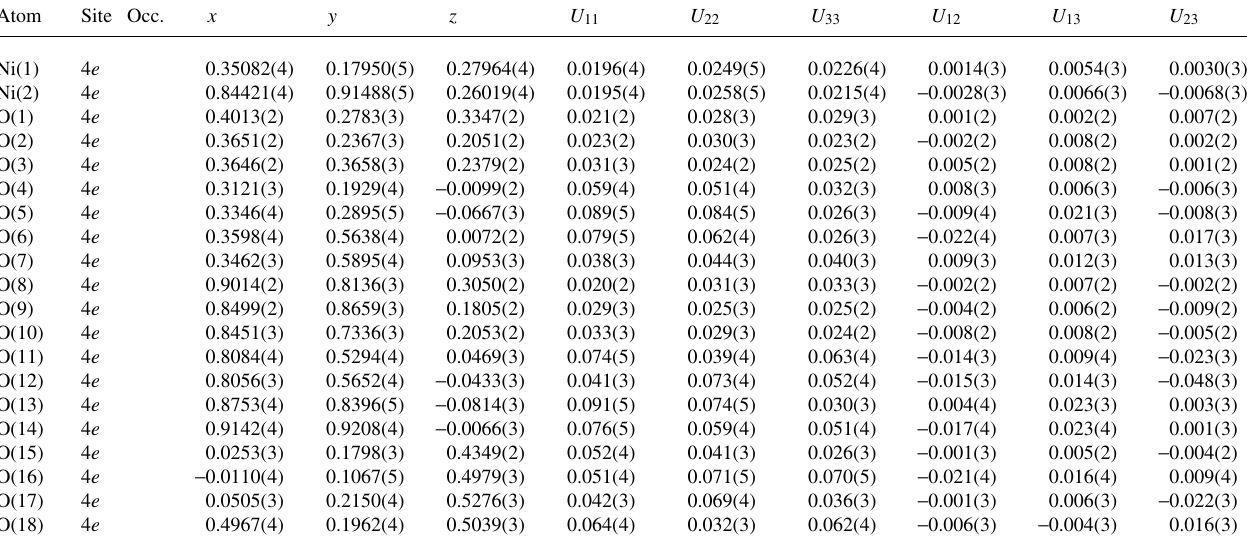
Table 3. Atomic coordinates and displacement parameters (in Å 2 ) .